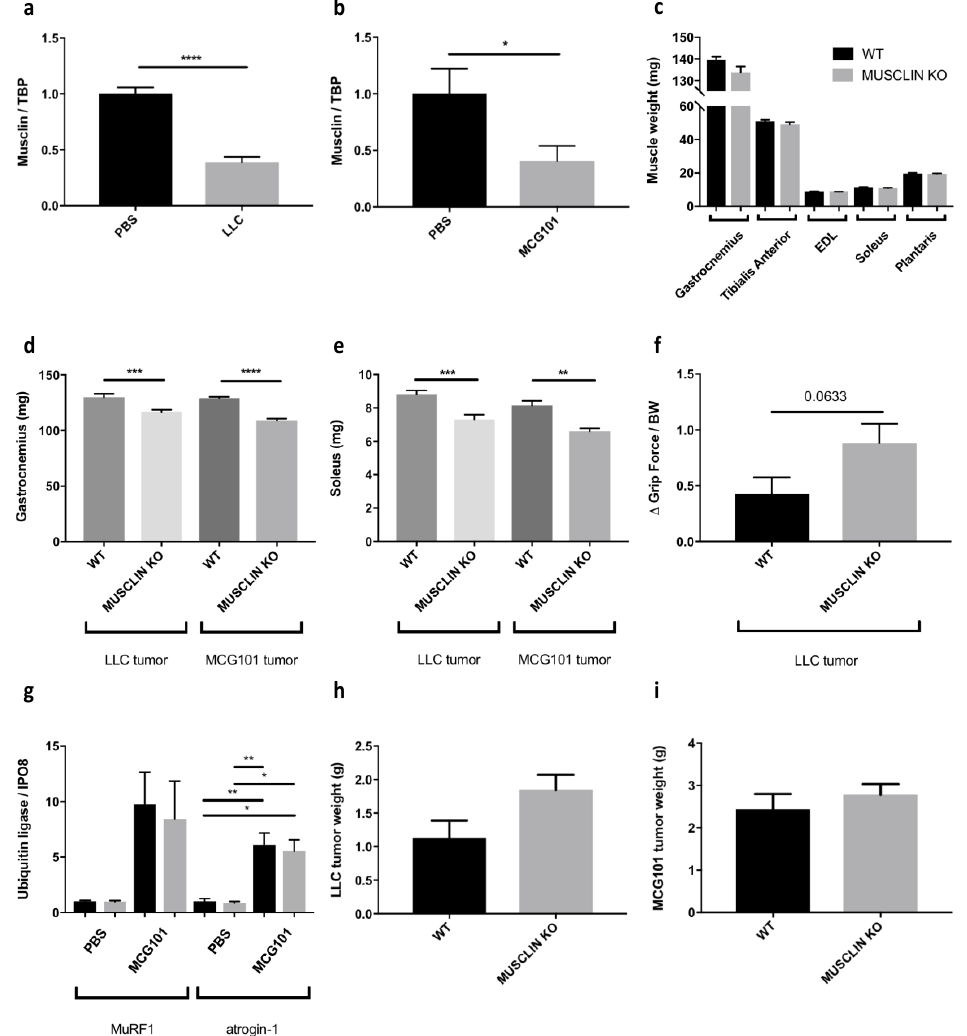
Figure 4. Musclin-knockout (KO) mice undergo more muscle depletion in response to cachexia-inducing tumors, as Lewis lung carcinoma (LLC) and methylcholanthrene-induced sarcoma 101 (MCG101). The expression of musclin has been measured in Tibialis Anterior (TA) from LLC- ( a ) or MCG101-bearing mice ( b ) at times when they suffer from cachexia. TBP was used as housekeeping gene and values normalized to phosphate-buffered saline (PBS)-injected mice. Unpaired t test for ( a ),